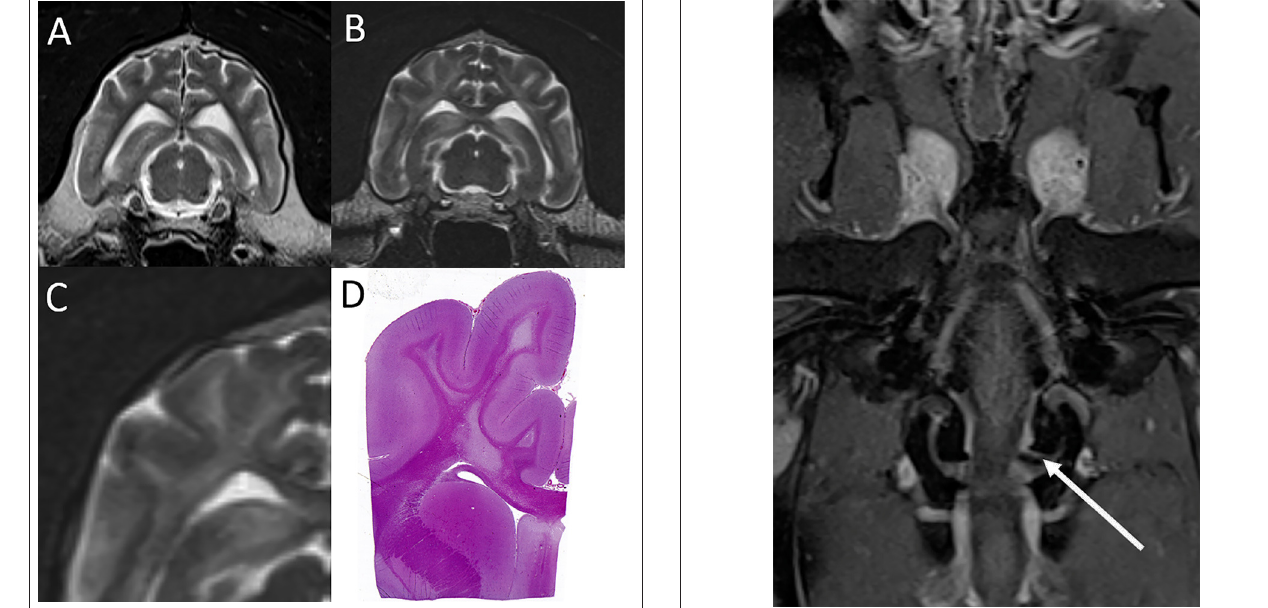
FIGURE 5 | Fracture of the left occipital condyle in a lion (arrow) which was best seen on this dorsal T1-W post contrast FatSat image. The caudal skull was only partially or not included in the scan field of view on most sequences, and the lesion was missed during the initial image